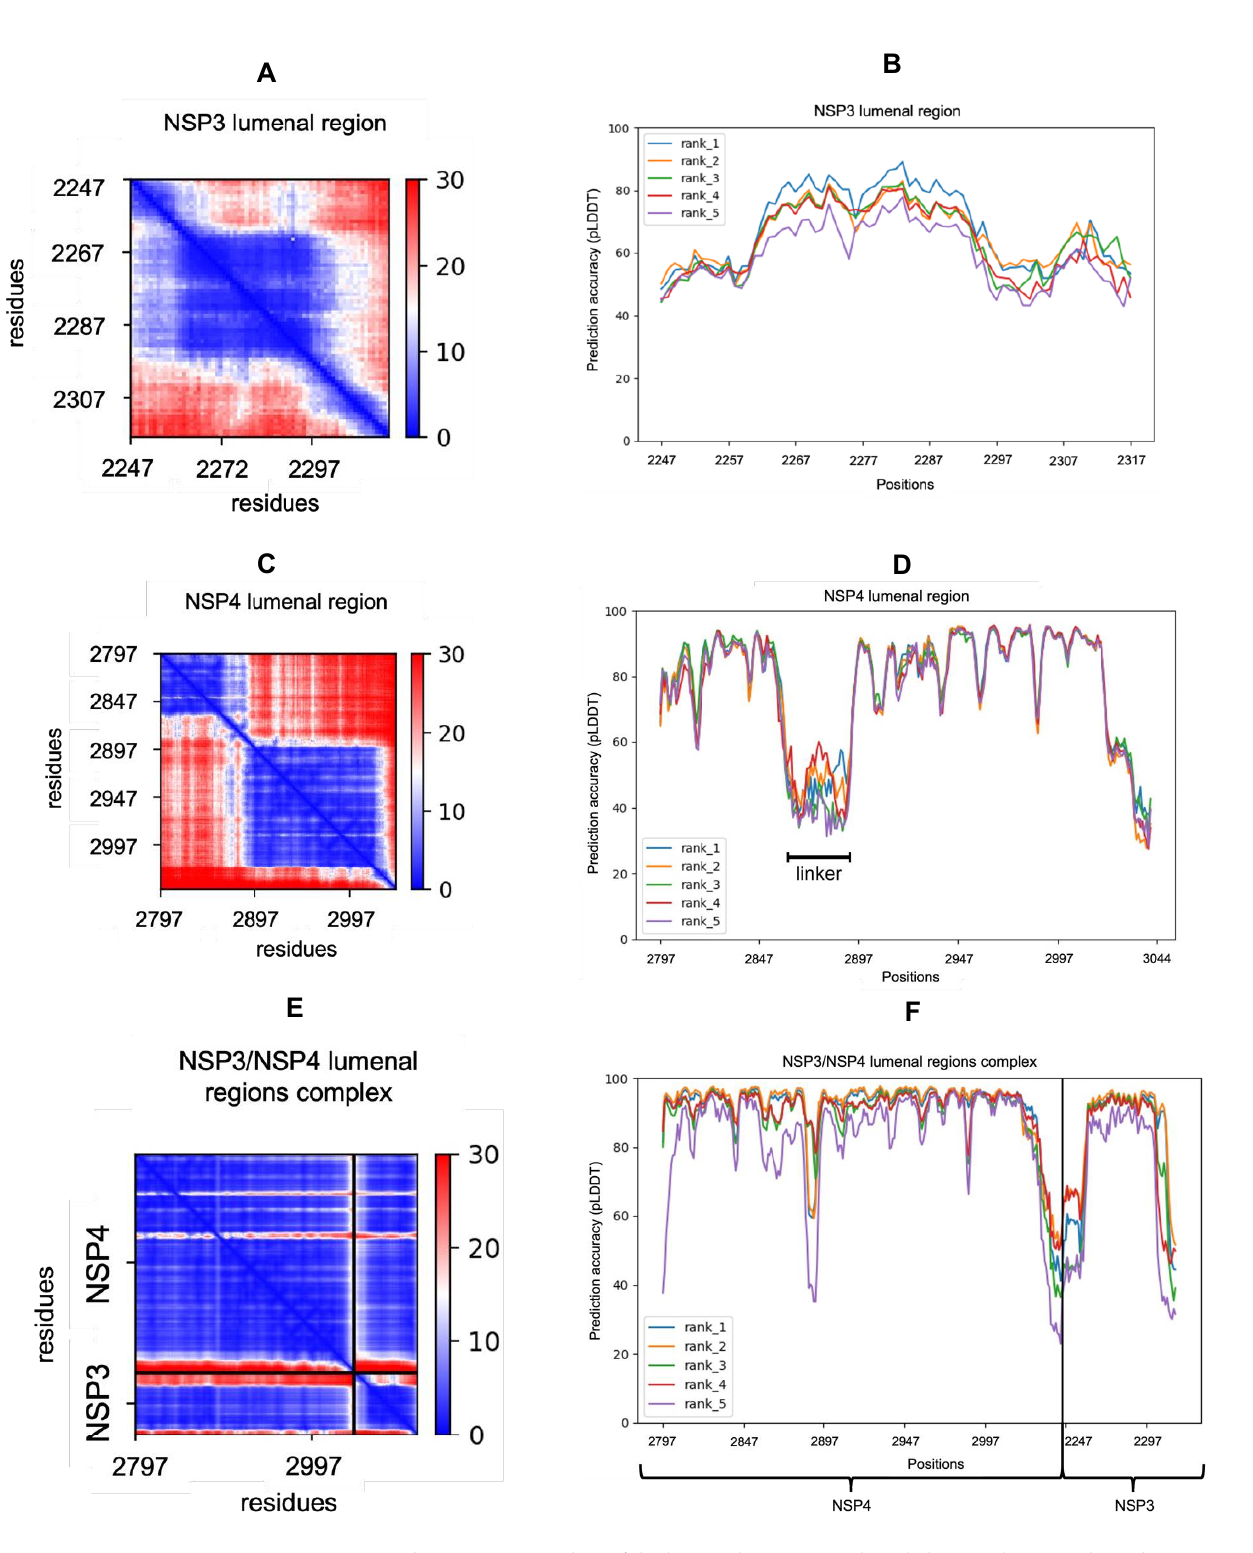
Figure 2. Quality assessment plots of the lumenal regions predicted alone and in complex. Blue positions in the PAE plots indicate low PAEs, red ones indicate high PAEs (measured in Angstroms). ( A ) PAE plot of the highest-ranked model of the nsp3 lumenal region. ( B ) Prediction accuracy pLDDT) plot of the five nsp3 lumenal region models (ranks 1–5). ( C ) PAE plot of the highest-ranked model of the nsp4 lumenal region. ( D ) Prediction accuracy plot of the five nsp4 lumenal region models. ( E ) PAE plot of the highest-ranked model of the nsp3 and nsp4 lumenal regions in complex. ( F ) Prediction accuracy plot of the five models of the lumenal regions of nsp3 and nsp4 in